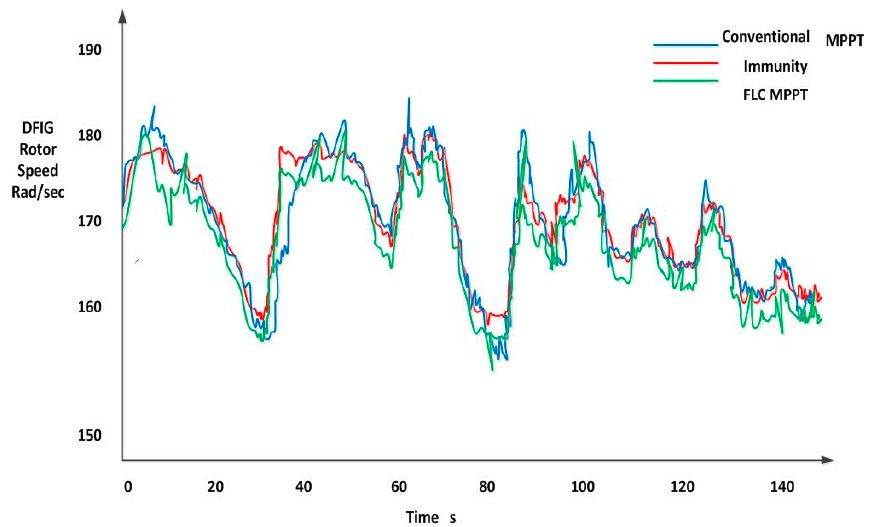
Figure 15. The comparison of DFIG rotor speed for different types of Eco-MPPT strategies (Conventional, AI and FLC).